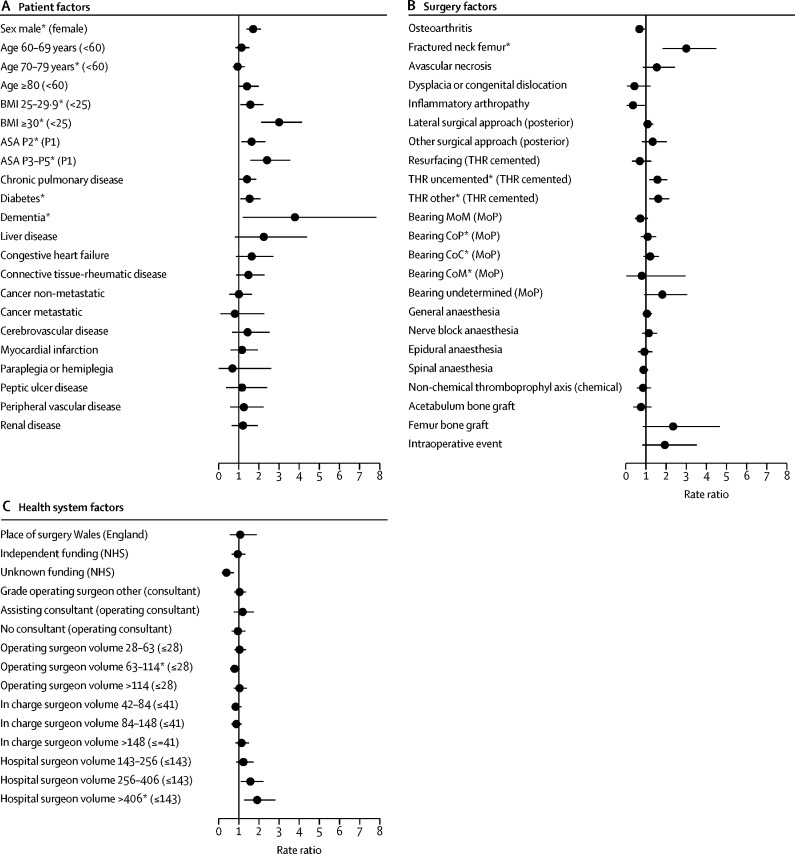
Risk factors of revision for prosthetic joint infection for the first 3 postoperative monthsReference category in parentheses. BMI=body-mass index. ASA=American Society of Anaesthesiologists. THR=total hip replacement. MoM=metal-on-metal. MoP=metal-on-polyethylene. CoP=ceramic-on-polyethylene. CoC=ceramic-on-ceramic. CoM=metal-on-ceramic. *Adjusted p value <0·05 (details in the appendix alongside the rate ratios and 95% CIs).